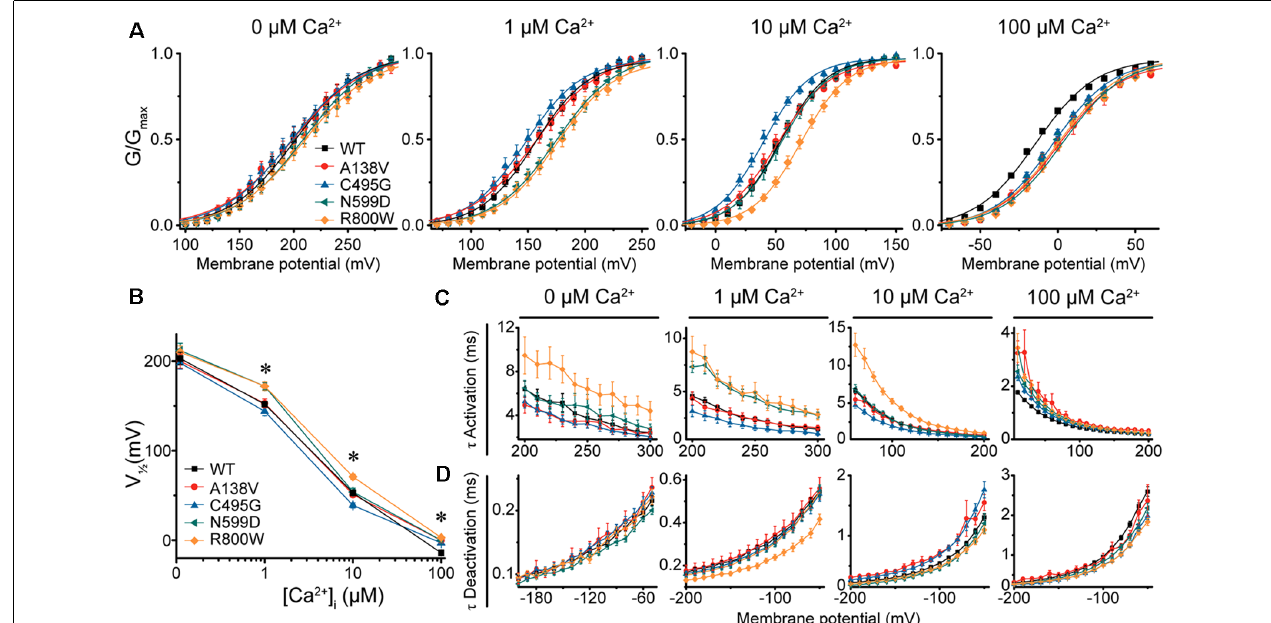
FIGURE 3 | BK current properties from SNP-containing hBK QEERL channels. (A) G–V relationships for BK currents recorded in symmetrical K + at 0-, 1-, 10-, and 100- µ M Ca 2 + for control wild-type (WT) hBK QEERL channels and channels containing A138V, C495G, N599D, or R800W SNP substitutions. Voltage protocols were identical to those in Figure 2 . (B) V 1 / 2 vs. Ca 2 + plot demonstrating differences in voltage dependence of activation between WT and SNP-containing channels. Significant differences were found at 1- (N599D, P = 0.02; R800W, P = 0.03), 10- (C495G, P = 0.02; R800W, P < 0.0001), and 100- µ M Ca 2 + (A138V, P = 0.001; C495G, P = 0.009; N599D, P = 0.0001; R800W P < 0.0001). ∗ P < 0.05, one-way ANOVA with Bonferroni post hoc test. (C) τ Activation vs. voltage at each Ca 2 + concentration. Significant differences in activation kinetics between WT and SNP-containing channels were observed at 0- (R800W, P = 0.03), 1- (C495G, P = 0.03; N599D, P = 0.0001; R800W, P = 0.002), 10- (C495G, P = 0.002; R800W, P < 0.0001), and 100- µ M Ca 2 + (A138V, P = 0.0006; C495G, P = 0.0007; N599D, P = 0.001; R800W, P < 0.0001). (D) τ Deactivation vs. voltage at each Ca 2 + . Significant differences in deactivation kinetics were found between WT and SNP-containing channels at 1- (R800W, P = 0.001), 10- (A138V, P = 0.002; C495G, P = 0.0005), and 100- µ M Ca 2 + (C495G, P = 0.0001; N599D, P = 0.02; R800W, P < 0.0001). Significant differences ( P < 0.05) in current kinetics between WT and each SNP-containing construct were determined using two-way repeated measures ANOVAs at each Ca 2 + . N = 5–28 recordings per construct at each Ca 2 +